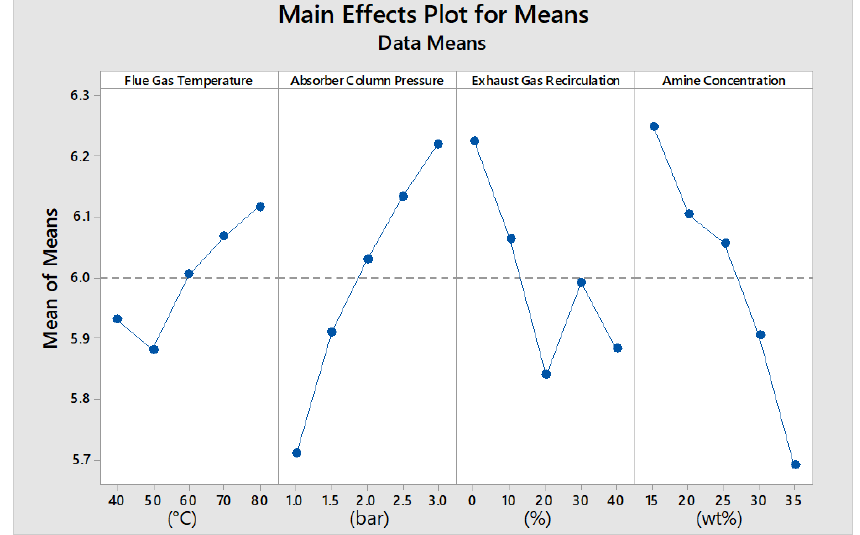
Figure 5. Main effects plot for the mean total energy requirement.